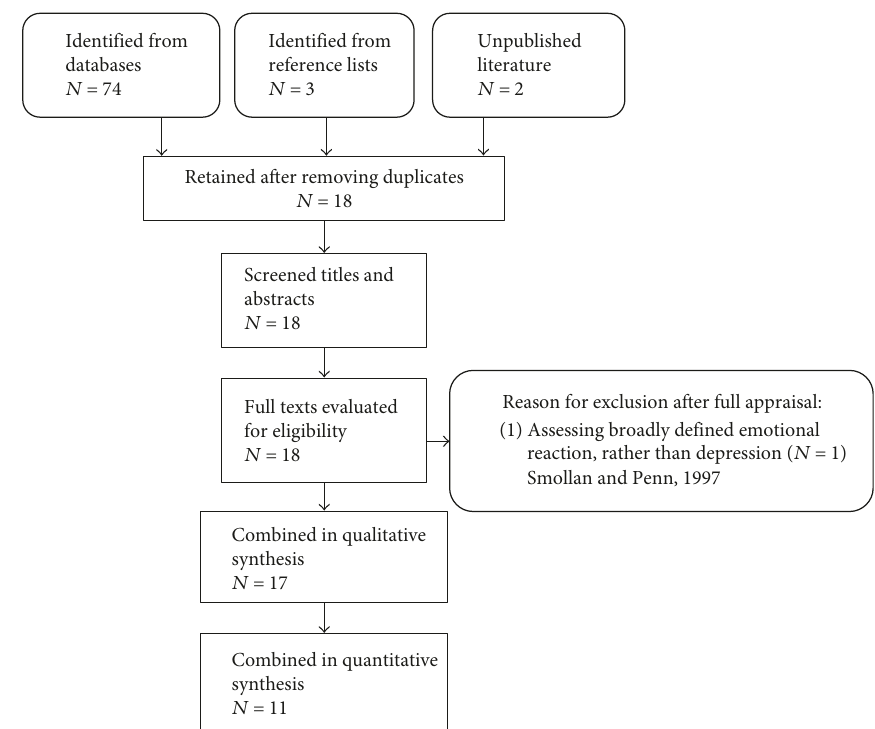
Figure 1: Flow chart showing details of included and excluded